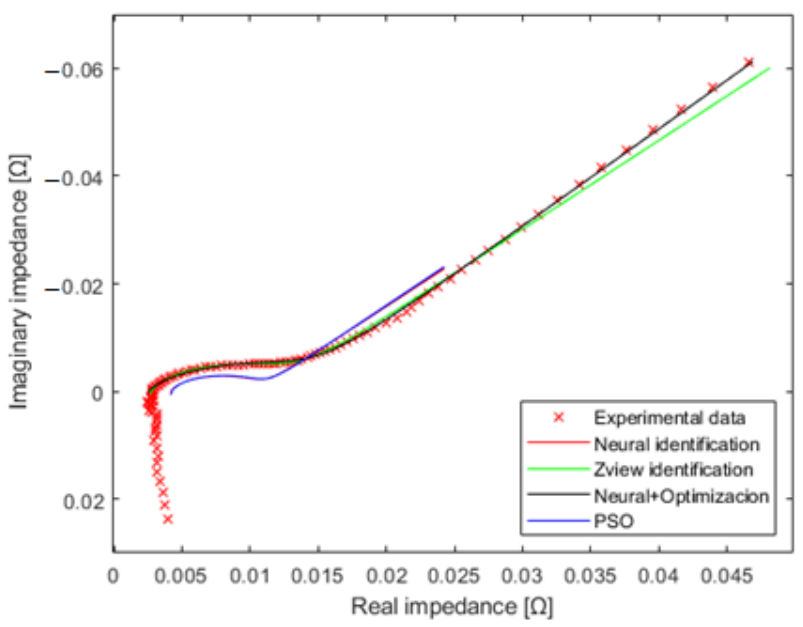
Figure 10. Final results and comparison with the experimental data .